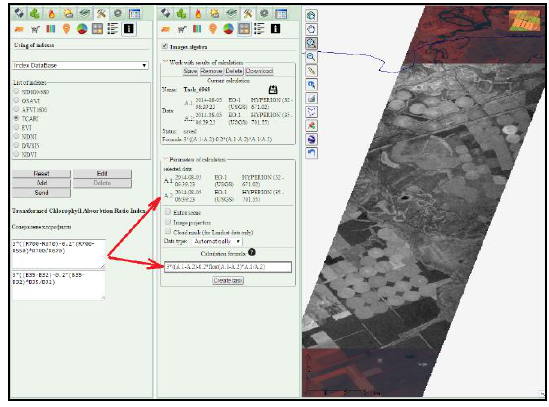
Figure 13. TCARI map of irrigated agriculture area (Hyperion, 05.08.2014, Saratov region).